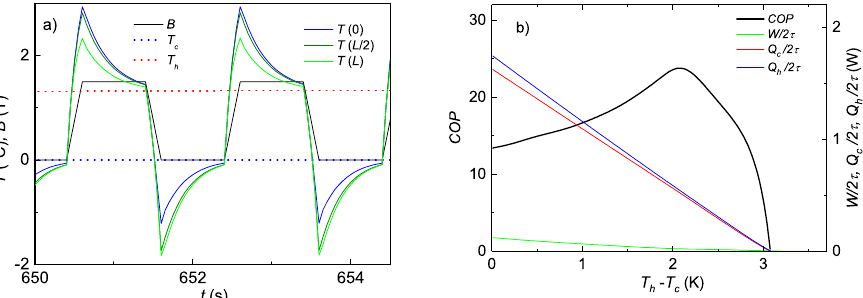
Figure 6. Pure MC refrigeration with thermal diodes. ( a ): Time evolution of temperatures at three points of the MCM, along with the temperatures of the cold source, T c , the hot sink, T h , and the magnetic field B ( t ) . T h is forced to increase slowly with time. ( b ): COP , average heat powers extracted and released, and average work power over one